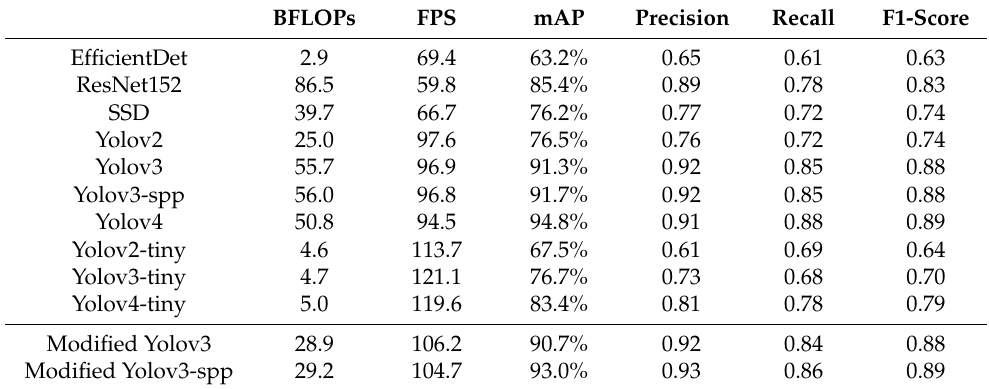
Table 4. Performance comparison of the proposed method with other networks on training